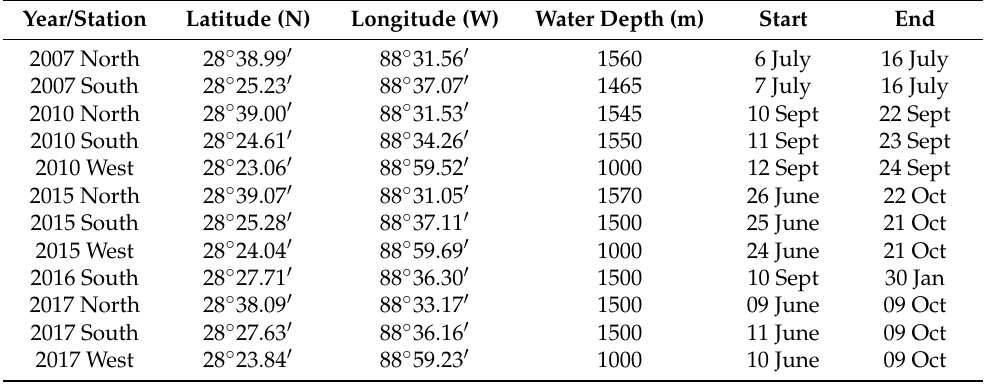
Geographic locations of EARS buoy moorings and the start/deployment and end/retrieval